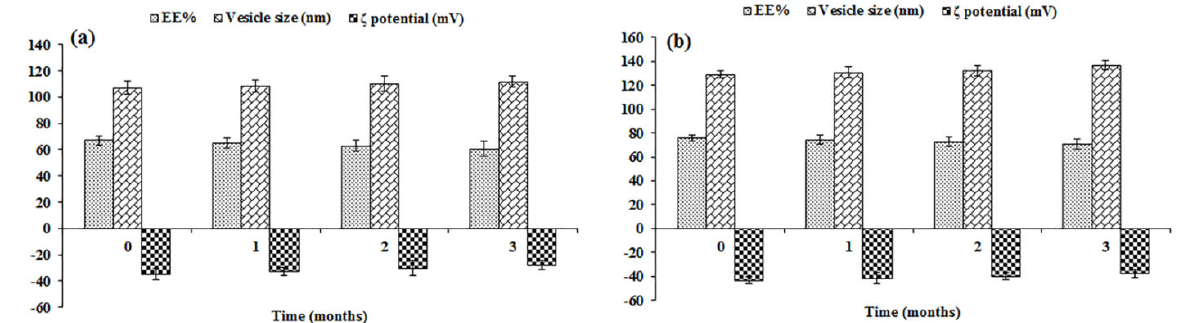
Figure 4. Effect of storage on EE%, vesicle size, and ζ potential of ( a ) QRC ‐ NOVs, and ( b ) QRC ‐ SeNOVs.